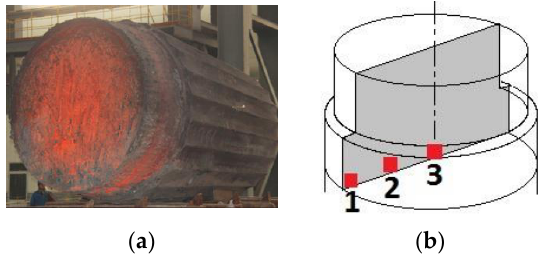
Figure 1. ( a ) The 40 MT cast ingot after stripping out of the mold; ( b ) three regions subjected to chemical and microstructure